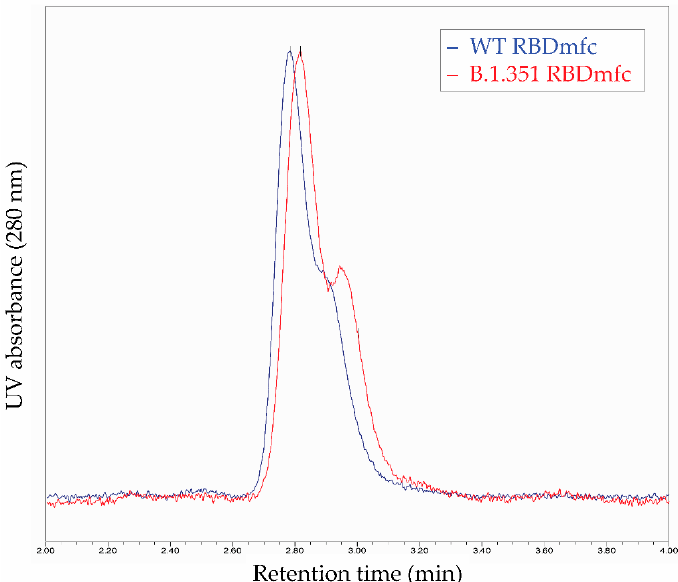
Figure 8. Size-exclusion chromatography (SEC) of WT and B.1.351 RBDmfc proteins. SEC was conducted on secreted, purified WT and B.1.351 RBDmfc recombinant proteins. UV absorbance was monitored at 280 nm and plotted against the retention time. Retention time of both proteins was similar: 2.79 and 2.82 min for WT and B.1.351 RBDmfc proteins, respectively. SEC thus confirmed the homogeneity in molar mass of WT and B.1.351 RBDmfc recombinant proteins, in agreement with HIC-MALS (Figure 6) and intact mass spectrometry (Figure 7) data. SDS-PAGE and silver staining analysis of the fractions isolated by HIC-MALS re- vealed that the two main peaks in WT and B.1.351 RBDmfc preparations corresponded to the protein population with higher apparent MW (~105 and 120 kDa) (Figure 6b, lanes 2– 5 of left panel and lanes 4–7 of right panel). On the other hand, the B.1.351 RBDmfc protein population with lower hydrophobicity corresponded to the population with lower appar- ent MW (~85 kDa) (Figure 6b, see * in lanes 1–4 of right panel). The observation that a fraction of B.1.351 RBDmfc proteins with similar molar mass exhibited a lower apparent MW on SDS-PAGE, together with a lower hydrophobicity, strongly suggests that this pro- tein population presents a different conformation compared to the proteins with higher apparent MW. Finally, thermograms of the purified WT and B.1.351 RBDmfc secreted proteins were established by differential scanning calorimetry (DSC). After baseline subtraction and in- tegration of the signals, each tested variant showed two independent denaturation events at a half-denaturation temperature (Tm) of approximatively 46–49 °C and 77 °C, respec- tively (Figure 9b). Independent DSC experiments using mouse IgG2a and its Fab and Fc fragments showed that the thermal denaturation event occurring at Tm 77 °C corre- sponded to the Fc domain (Figure 9a, green curve), and consequently that the first dena- turation event at Tm 46–49 °C was related to the RBD subdomain (Figure 9b).